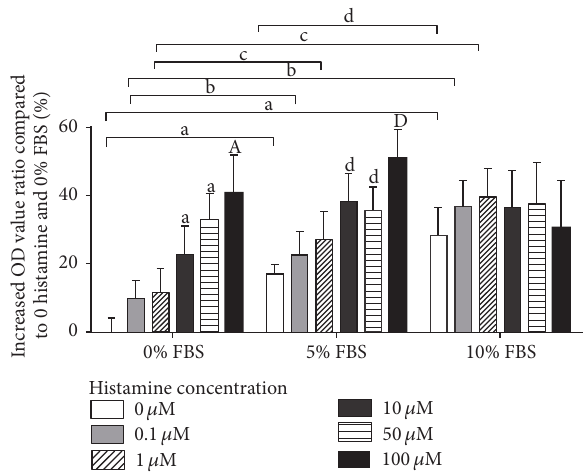
Figure 3: Histamine had a proliferative effect on HPFs. His- tamine promoted the proliferation of HPFs with concentrations of 10 𝜇 mol/L and above in the situations of 0% FBS and 5% FBS. High concentration (10–100 𝜇 mol/L) of histamine could partially cover the promotive effect of serum on HPFs. a 𝑃 < 0.05 compared to 0 histamine and 0% FBS, A 𝑃 < 0.01 compared to 0 histamine and 0% FBS, b 𝑃 < 0.05 compared to 0.1 𝜇 mol/L histamine and 0% FBS, c 𝑃 < 0.05 compared to 1 𝜇 mol/L histamine and 0% FBS, d 𝑃 < 0.05 compared to 0 histamine and 5% FBS, and D 𝑃 < 0.01 compared to 0 histamine and 5% FBS.